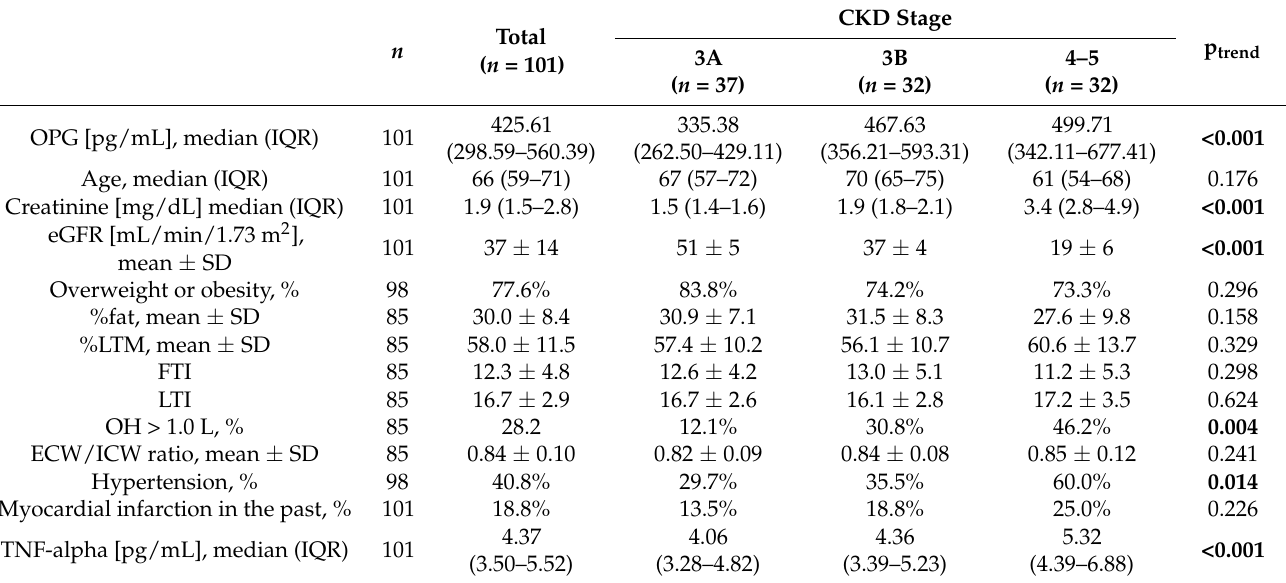
Table 2. Clinical characteristics of the study participants and prognostic factors for unfavorable CKD and cardiovascular outcomes.